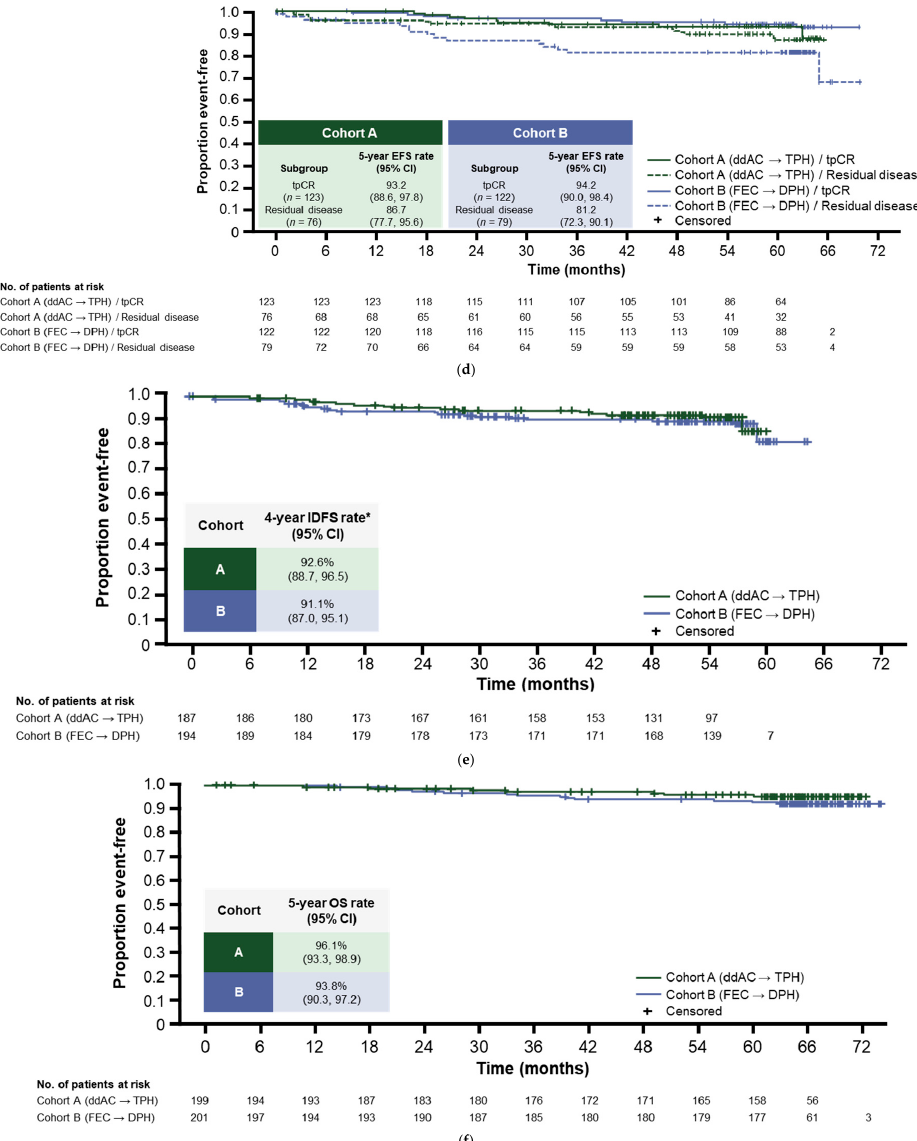
Figure 2. ( a ) EFS in the ITT population; ( b ) EFS in hormone receptor subgroups; ( c ) EFS by clinical nodal status; ( d ) EFS by tpCR status; ( e ) IDFS in the ITT population; ( f ) OS in the ITT population. CI, confidence interval; ddAC, dose-dense doxorubicin plus cyclophosphamide; EFS, event-free survival; DPH, docetaxel, pertuzumab, and trastuzumab; FEC, fluorouracil, epirubicin, and cyclophosphamide; HR, hormone receptor; IDFS, invasive disease-free survival; ITT, intention to treat; OS, overall survival; tpCR, total pathologic complete response (ypT0/is ypN0); TPH, paclitaxel, pertuzumab, and trastuzumab. The 4-year IDFS rate was 92.6% (95% CI: 88.7, 96.5) in Cohort A and 91.1% (95% CI: 87.0, 95.1) in Cohort B (Figure 2e).